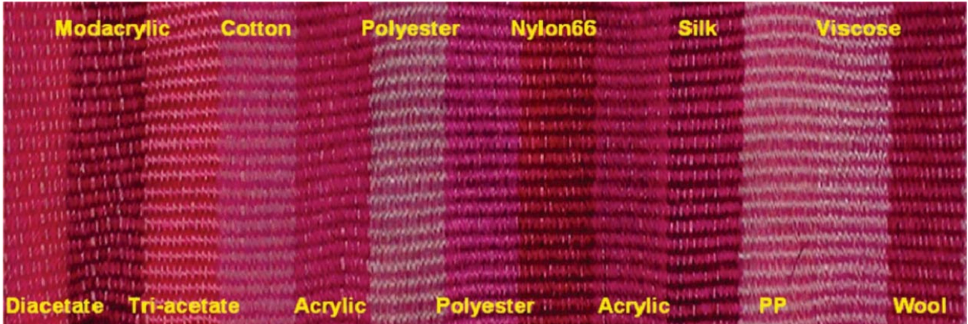
Figure 7. Multifiber fabrics dyed with prodigiosin isolated from Vibrio sp. KSJ45 (reprinted with permission from reference [8]. Copyright 2008